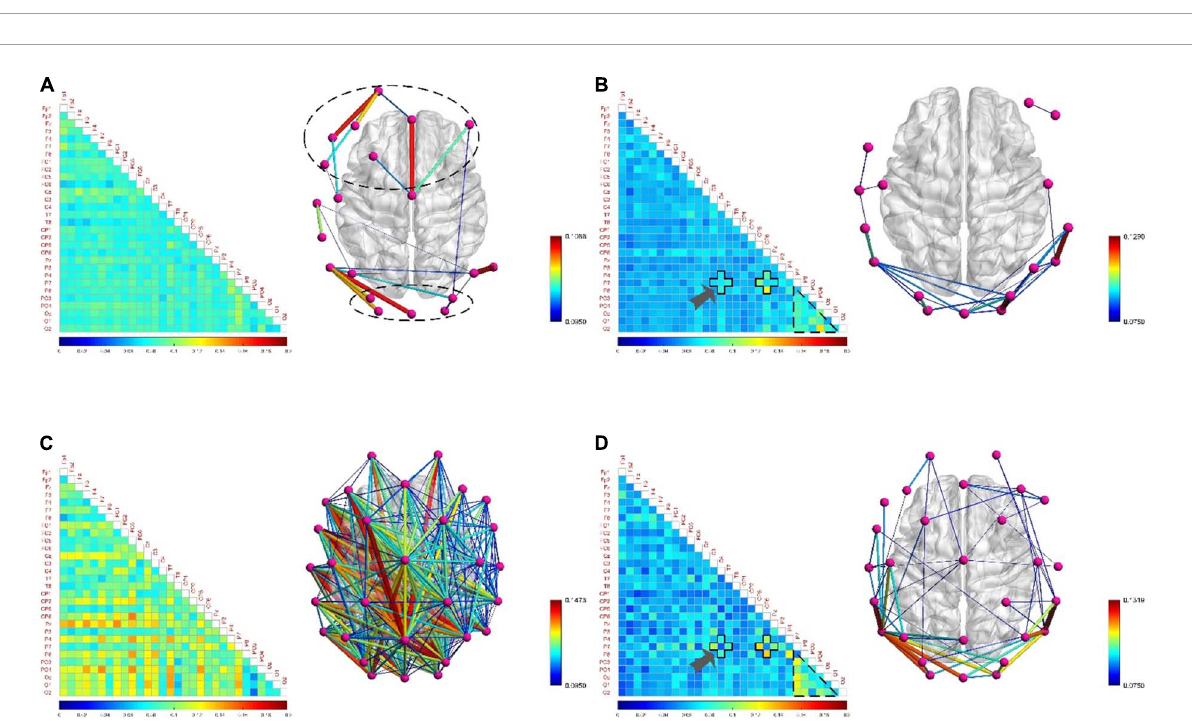
FIGURE9 The functional brain networks and connectivity matrices in attentive and inattentive states. (A) The situation when the electroencephalogram (EEG) is at low frequency in the attentive state. (B) The situation when the EEG is at high frequency in the attentive state. (C) The situation when the EEG is at low frequency in the inattentive state. (D) The situation when the EEG is at high frequency in the inattentive